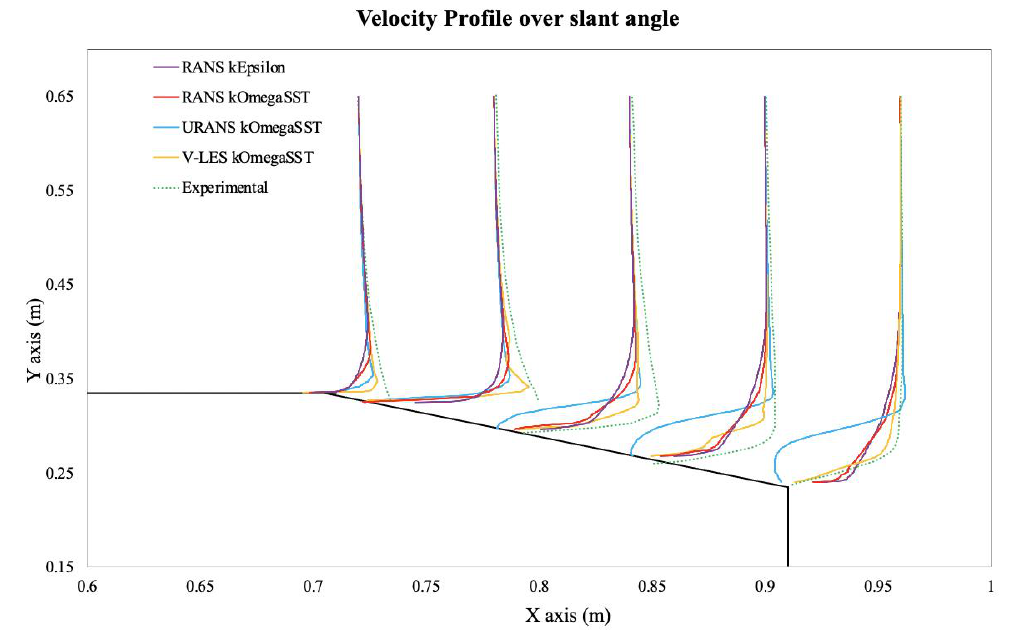
Figure 17. Velocity Profile over slant angle of Ahmed Body.